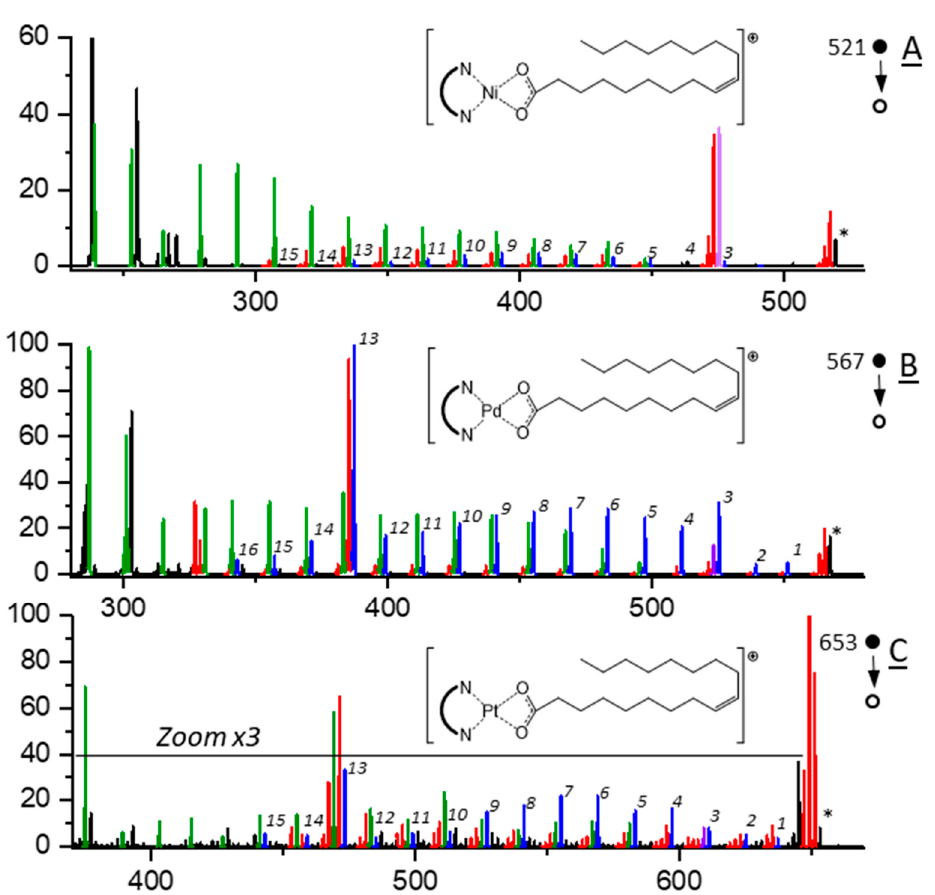
Figure 1. CID of [(phen)M(OOCC 17 H 33 )] + for M = Ni ( A ), Pd ( B ), and Pt ( C ). Red peaks correspond to dehydrogenation of the parent peak immediately to the right. Blue peaks are the result of cracking of the hydrocarbon chain without deoxygenation (number of neutral carbons lost in neutral molecule). Purple represents deoxygenation, while green indicates cracking of the hydrocarbon chain after deoxygenation. * indicates the mass-selected precursor ion.